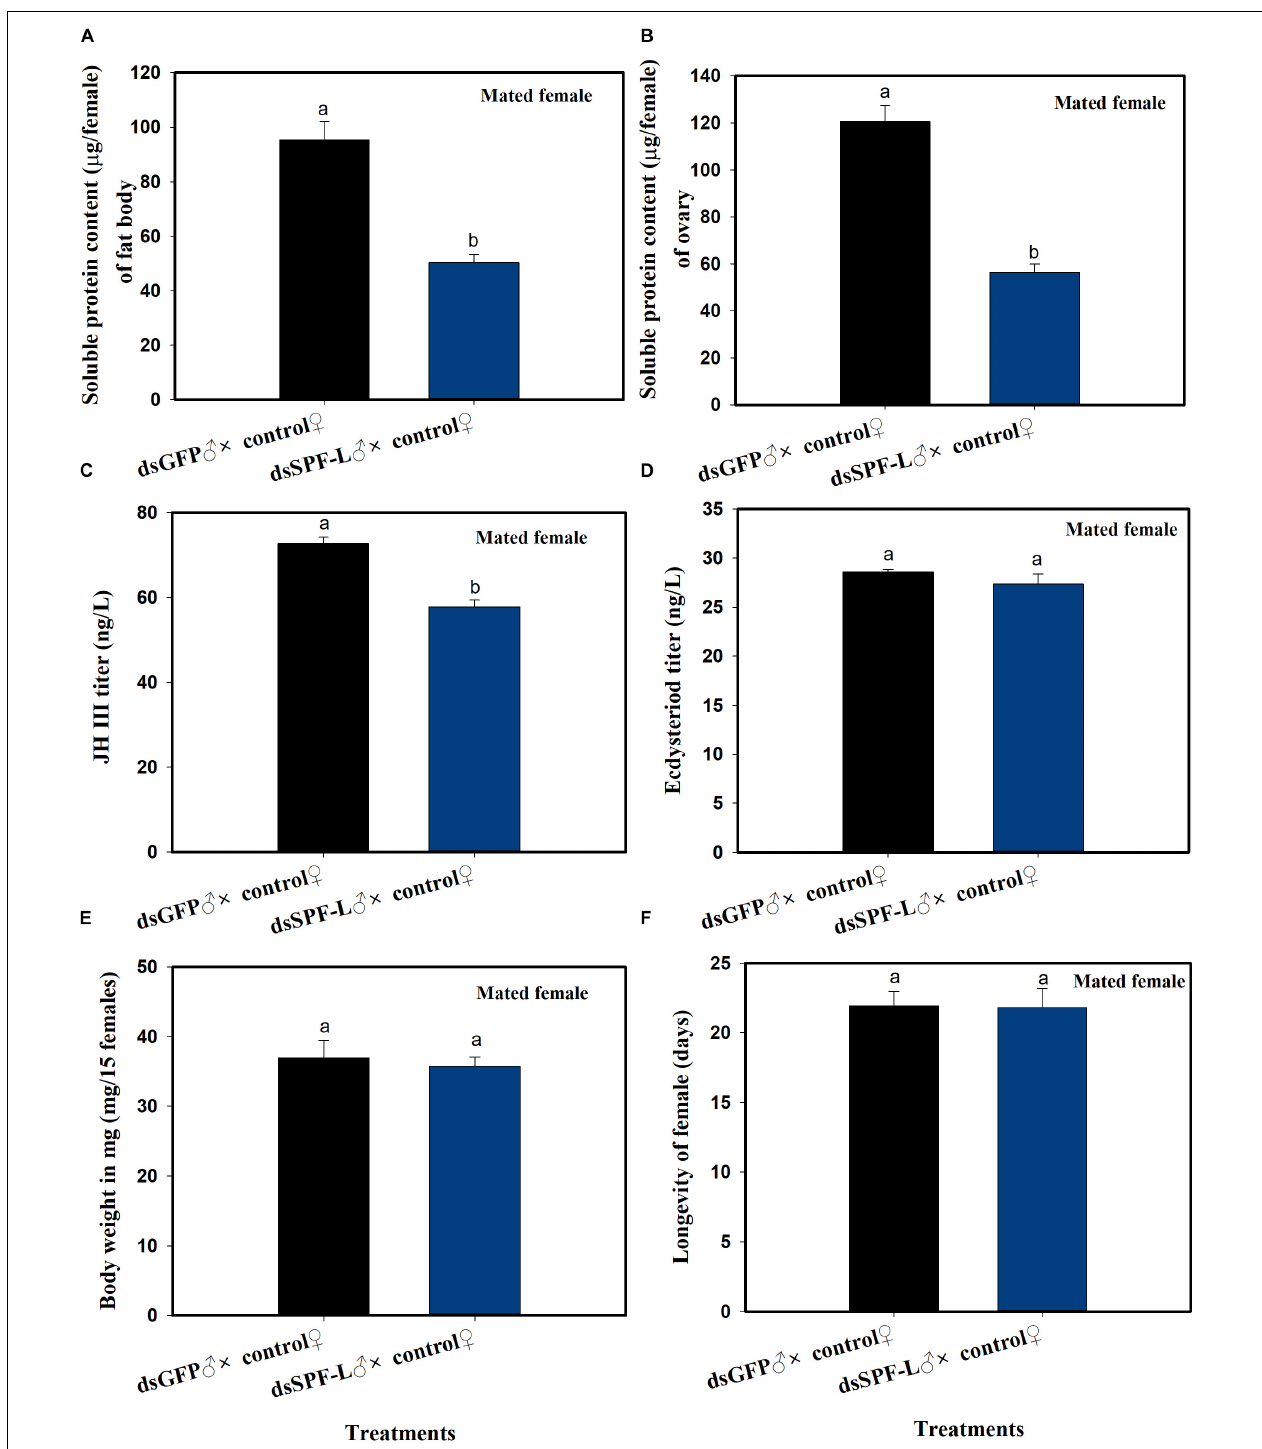
FIGURE 6 | The influence of mating with dsSPF-Ltreated males on females at 2 DAE. (A) The histogram bars show mean fat body soluble protein content in mated females ( n = 20, N = 3 independent biological replicates). (B) The histogram bars show mean ovarian soluble protein content in mated females ( n = 20, N = 3 independent biological replicates). (C) The histogram bars show mean JH III titer ( n = 3 independent biological replicates). (D) The histogram bars show mean ecdysteriod titer ( n = 3 independent biological replicated). (E) The histogram bars show mean body weight ( n = 15, N = 3 independent biological replicated). (F) The histogram bars show mean longevity of females ( n = 15 independent biological replicated). All error bars indicate 1 SEM. The histogram bars with different letters were significant difference at p < 0.05 (Student’s t -test).